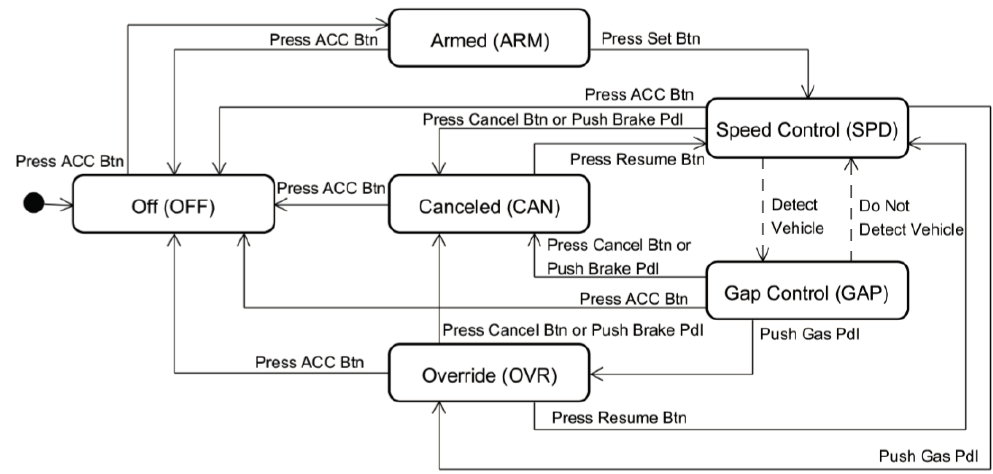
Figure 3. Traditional machine model of an ACC system composed of six